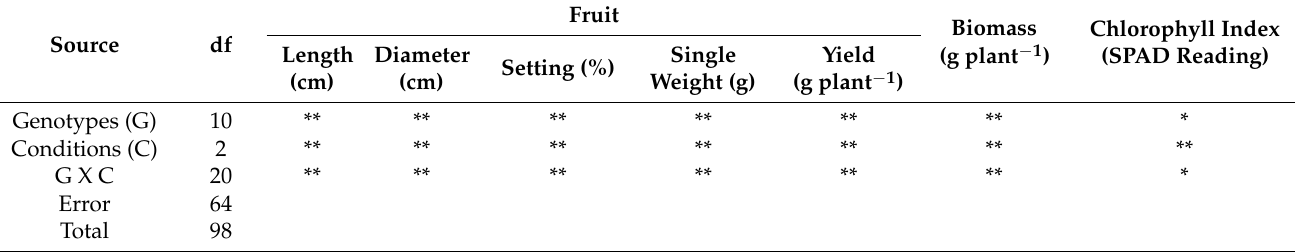
Table 1. Significance, analysis of variance effects of main and interaction effects for different traits of tomato.